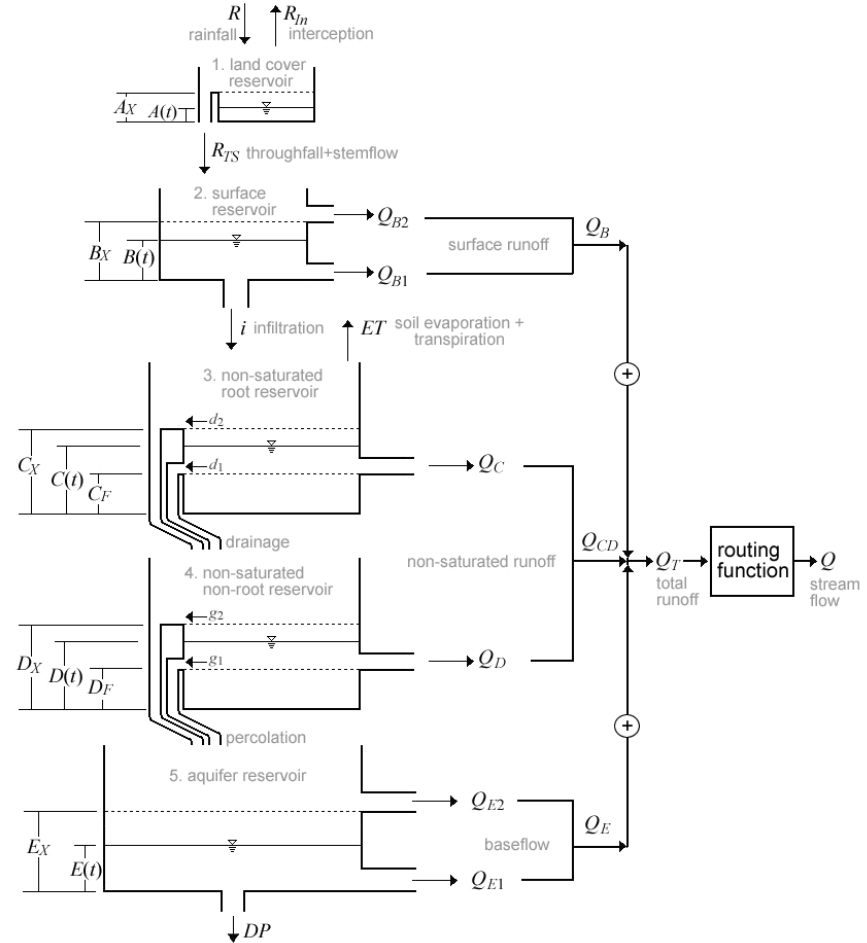
Fig. 3. The lumped conceptual hydrological model proposed for the experimental